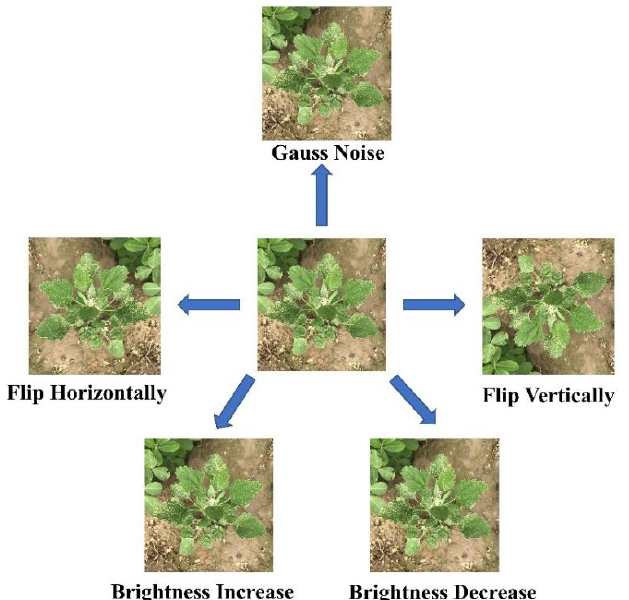
Figure 2. Data enhancement. Figure 2. Data